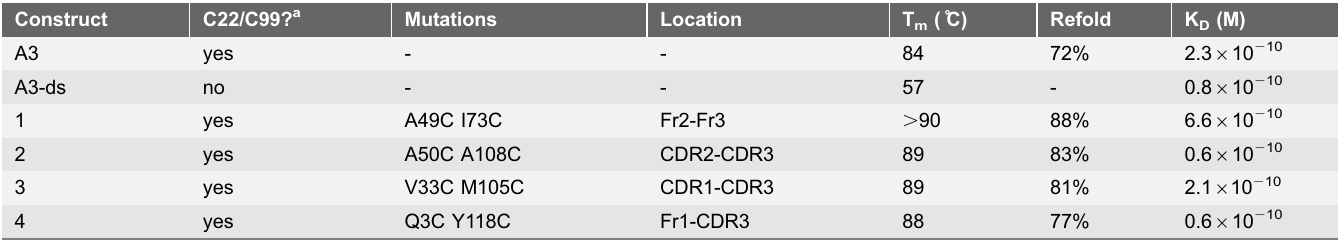
Table 1. Melting temperatures and